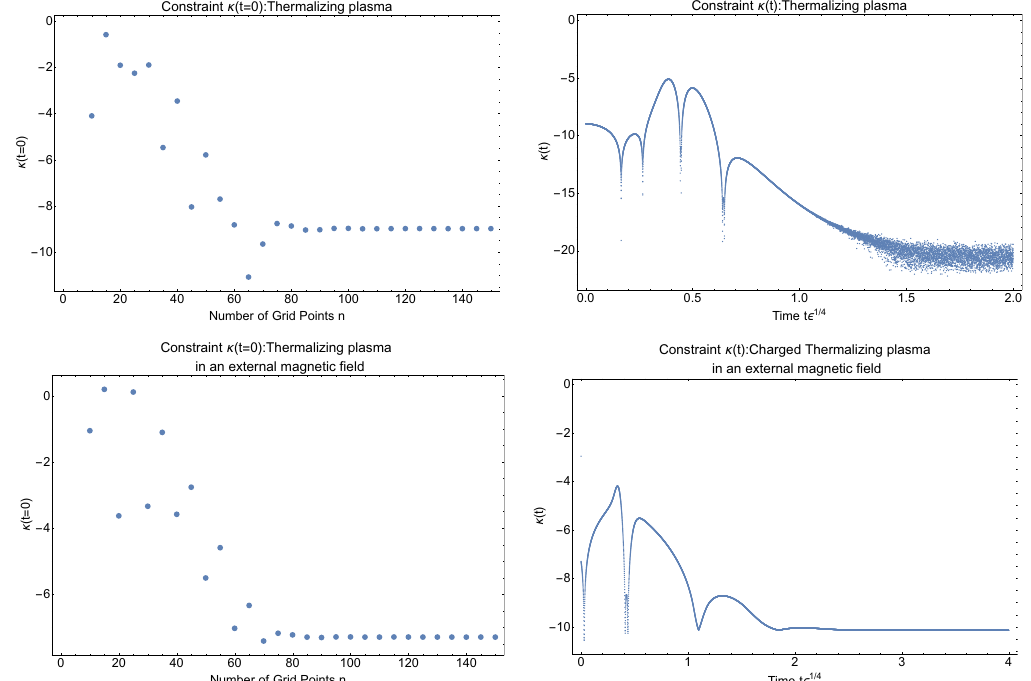
Figure 22 . Constraint violation measured by (cid:20) ( t ) for the generation of the anisotropic geometries used in the calculation of geodesics. We display on the left the constraint on the initial time slice and on the right the value of the constraint throughout the evolution of the geometry. Top left: (cid:26) = 0 ; B = 0. Top right: (cid:26) = 0 ; B = 0. Bottom left: (cid:26) = 0 : 78 (cid:26) e ; B = 3. Bottom right: (cid:26) = 0 : 78 (cid:26) e ; B =